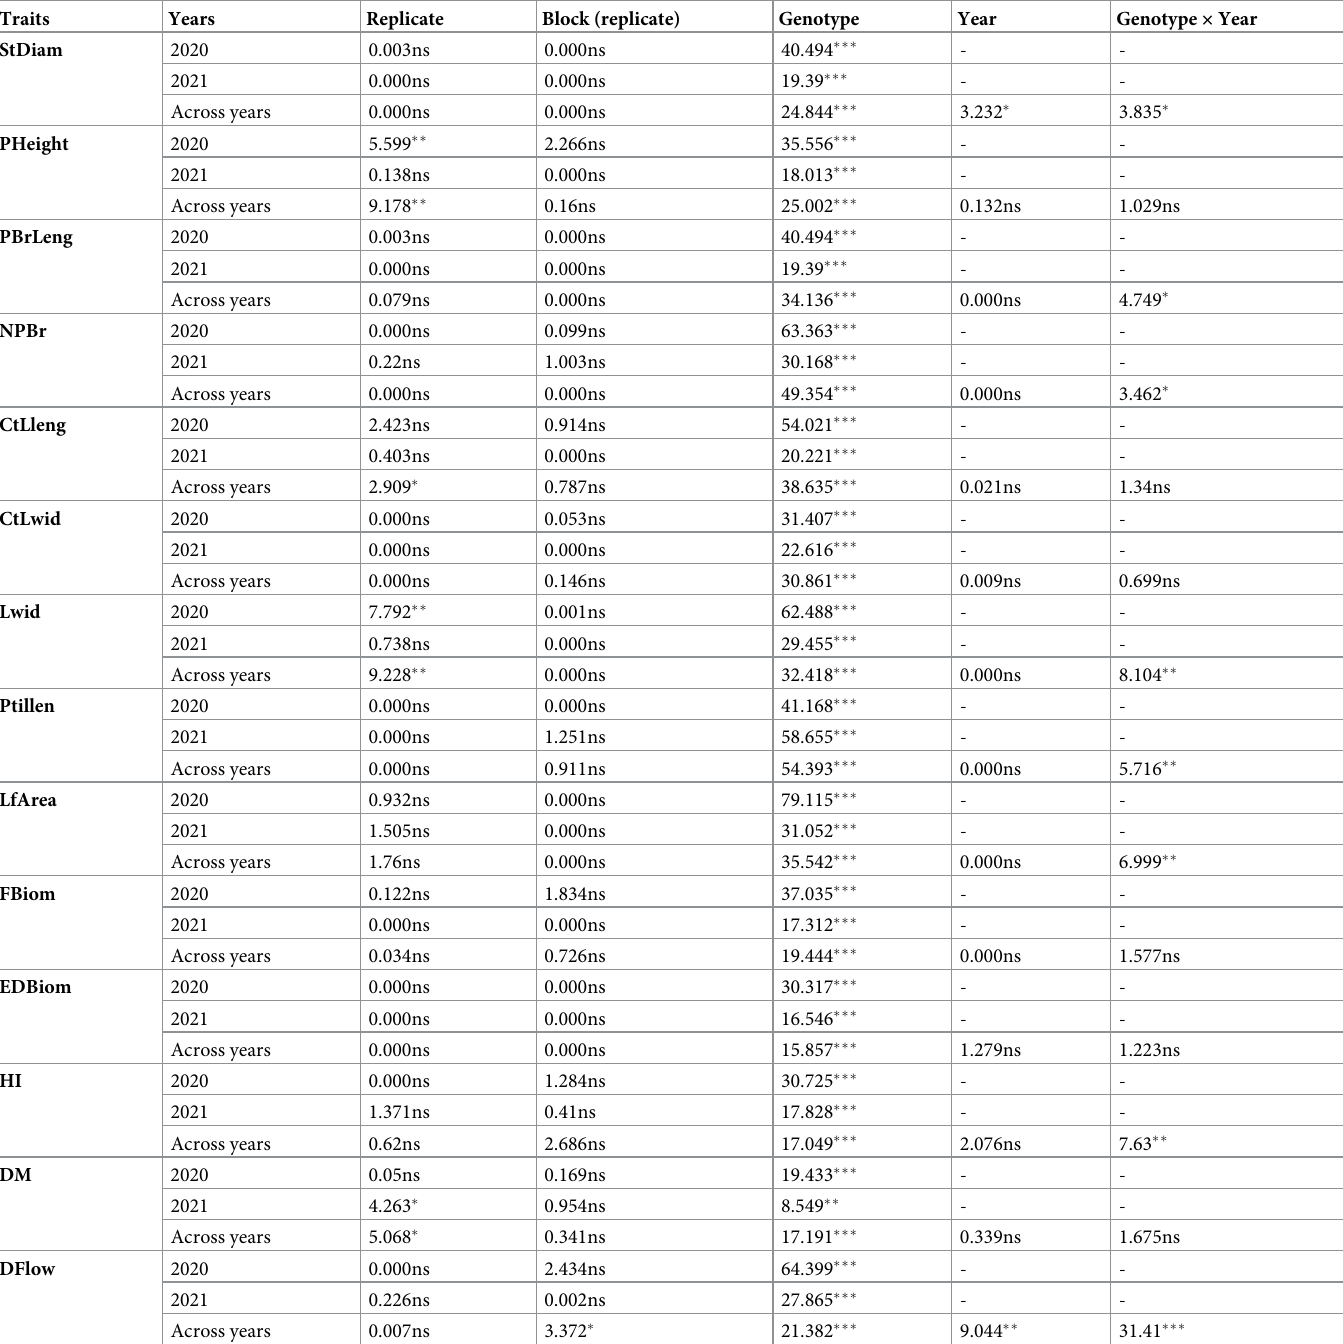
Table 3. Likelihood ratio test (LRT) for replicate, block, genotype, and genotype × year interaction effects regarding fourteen agronomic traits in 2020 and 2021, and across years for 71 advanced lines of Gynandropsis gynandra . Traits